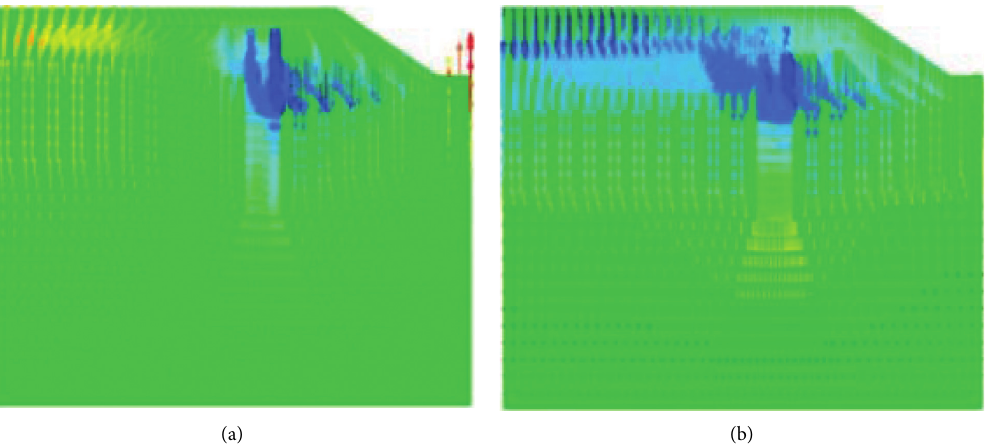
Figure 11: Settlement vector diagram of widened subgrade for a pile length under the existing subgrade and new embankment equal to 4.7m. (a) Settlement vector diagram of subgrade completion. (b) Settlement vector diagram 15 years following subgrade